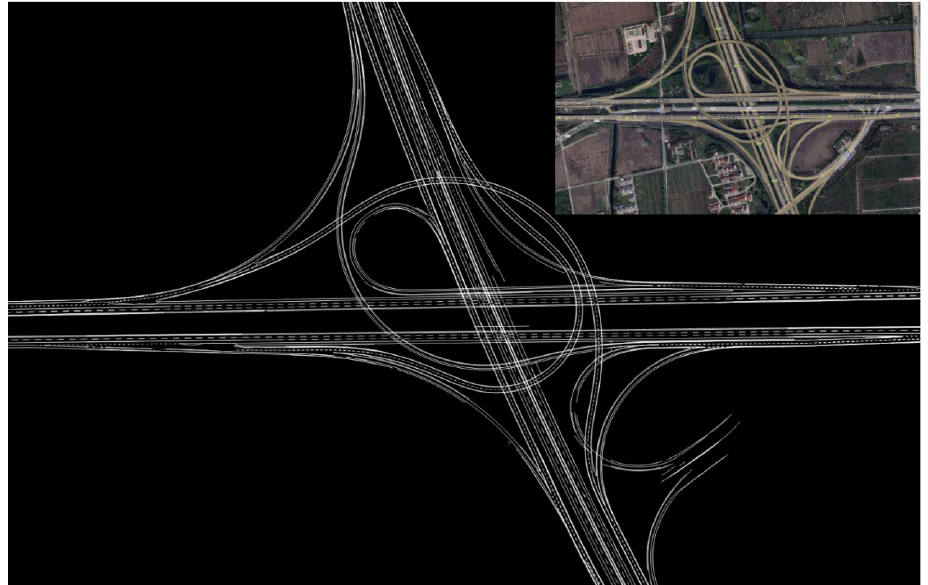
Figure 11. Automatic global consistency semantic map rendering.